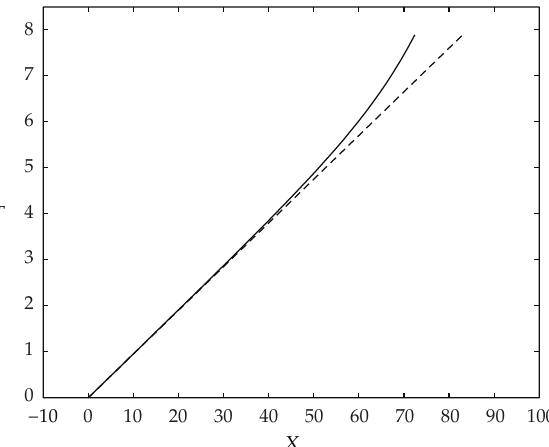
Figure 2: The trace of the vertex of solitary